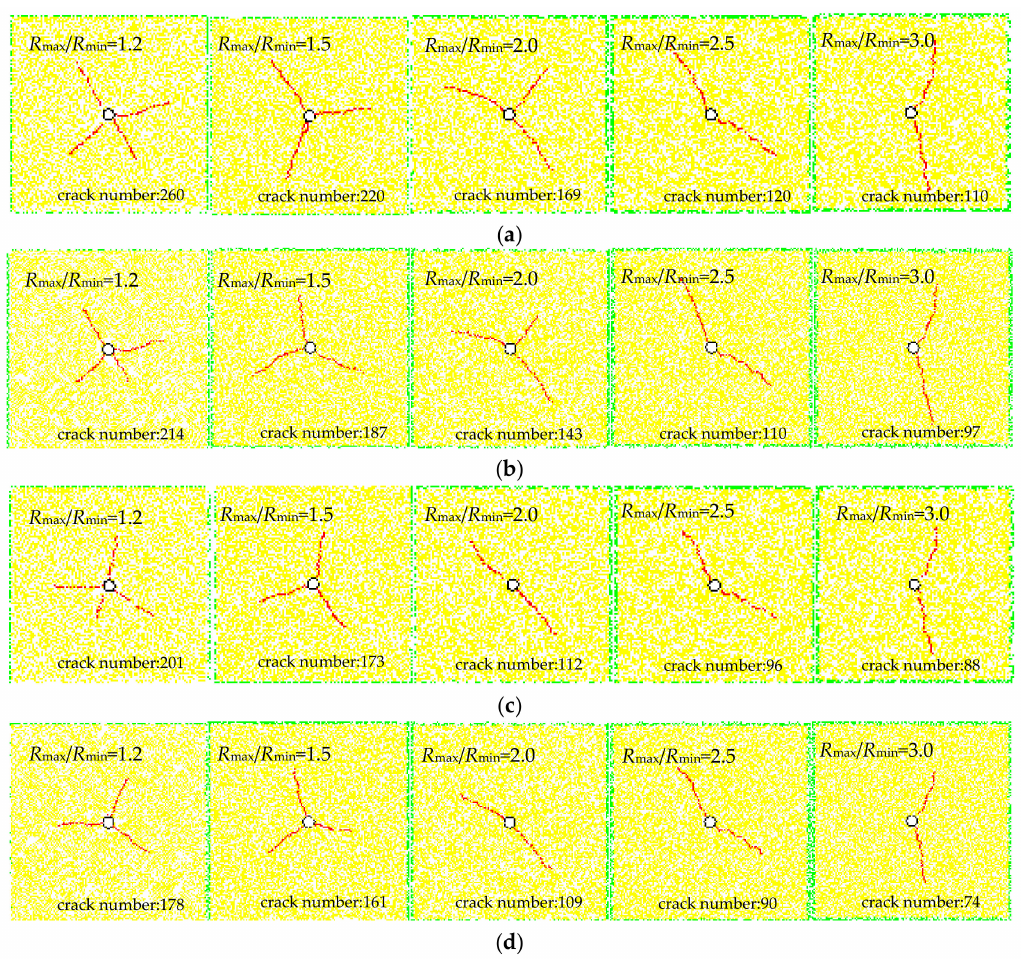
Figure 10. Distributions of hydraulic fractures under different grain size heterogeneity and